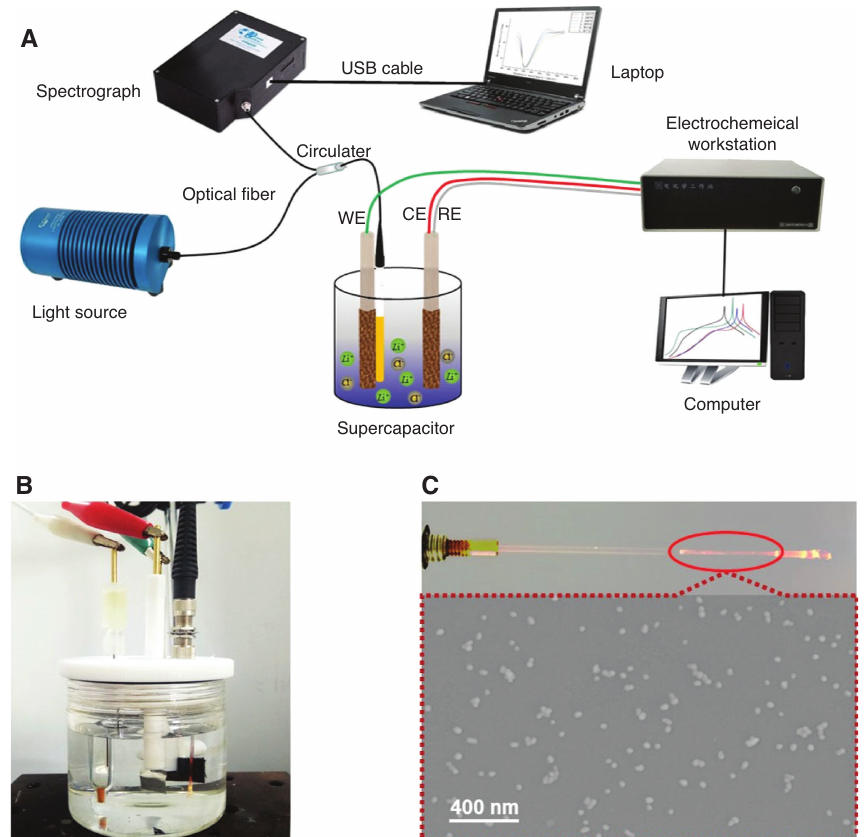
Figure 2: Fiber-optic LSPR sensor for in situ monitoring the state of charge in supercapacitor. (A) Schematic representation of instrumental sensing system for fiber-optic LSPR sensor monitoring the charge and discharge process in supercapacitor. (B) The picture of in situ monitoring supercapacitor with fiber-optic LSPR sensor. (C) Optical and SEM image of sensing surface of the fiber-optic LSPR